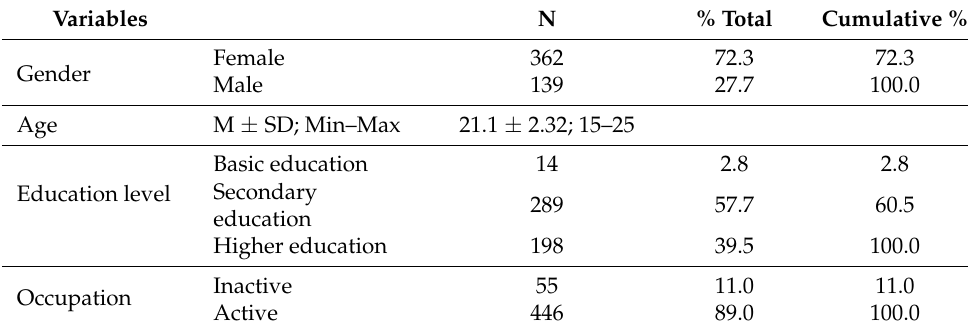
Table 1. Sociodemographic characteristics: respondents’